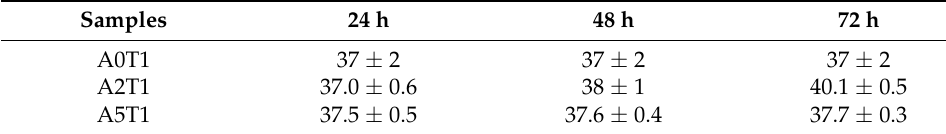
Table 5. Diameter of the growth inhibition halos (mm) on time.